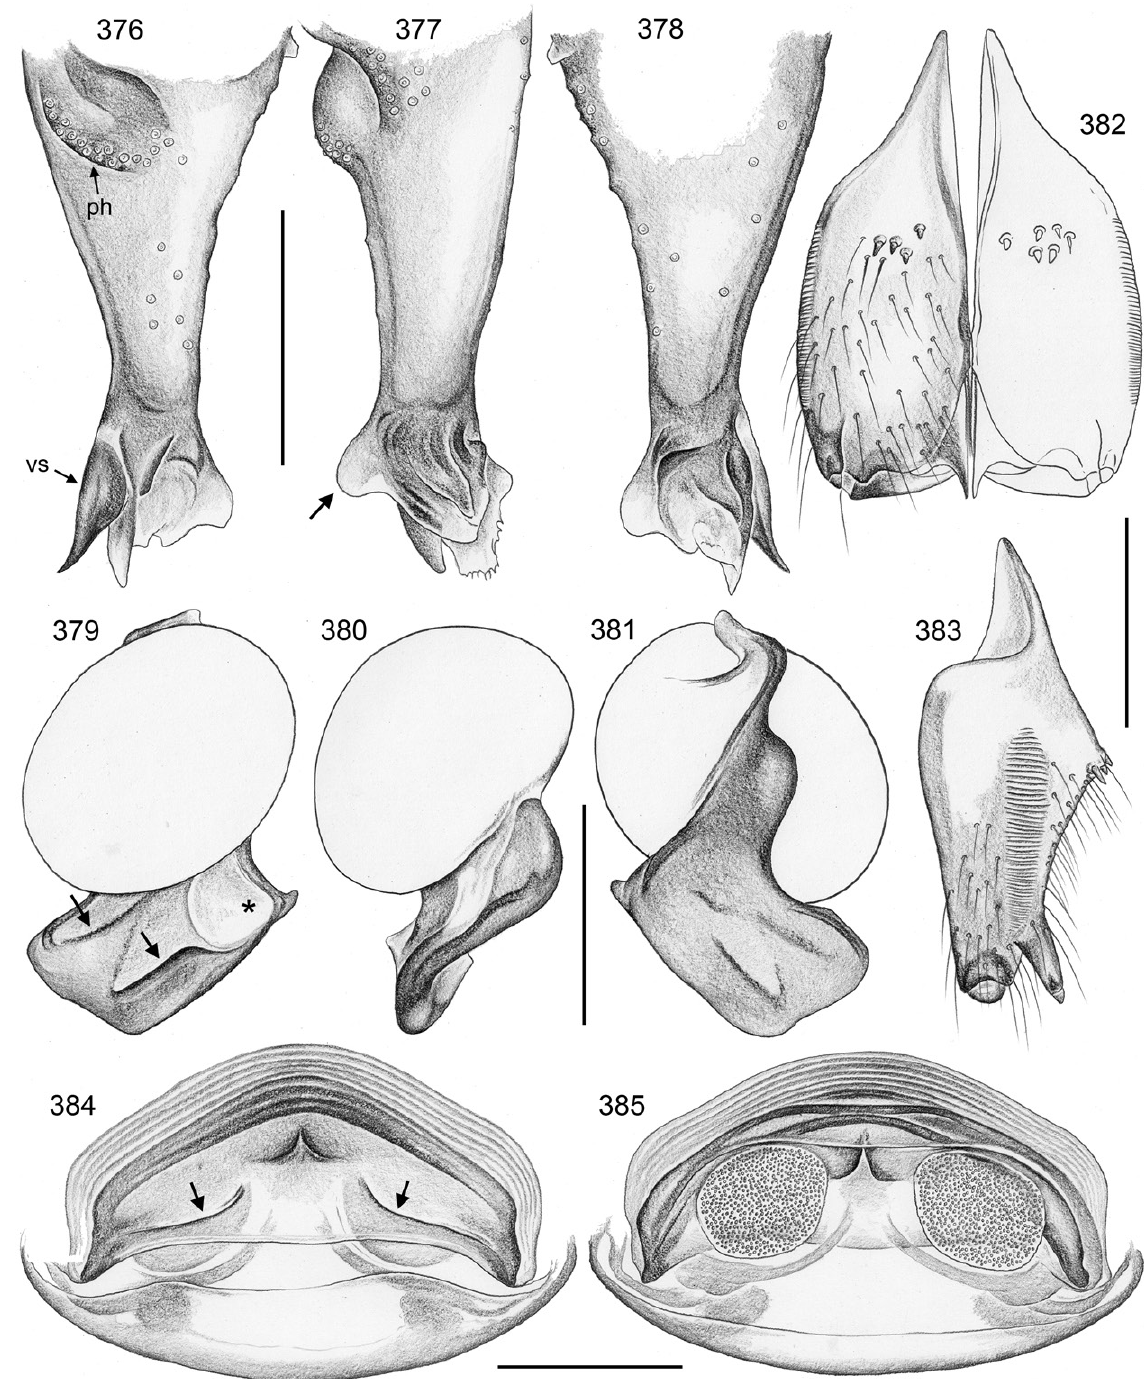
Figs 376–385. Crossopriza illizi sp. nov.; male from Algeria, Iherir (CRB), female from Algeria, Aguelmane ti-n-Azzaret (CRB). 376–378 . Left procursus, prolateral, dorsal, and retrolateral views; arrow: prolateral process. 379–381 . Left genital bulb, prolateral, dorsal, and retrolateral views; arrows: distinctive ridges; asterisk: putative position of sperm duct opening. 382–383 . Male chelicerae, frontal and lateral views. 384–385 . Cleared female genitalia, ventral and dorsal views; arrows: pockets. Abbreviations: ph = prolateral hump; vs = ventral sclerite. Scale bars = 0.3